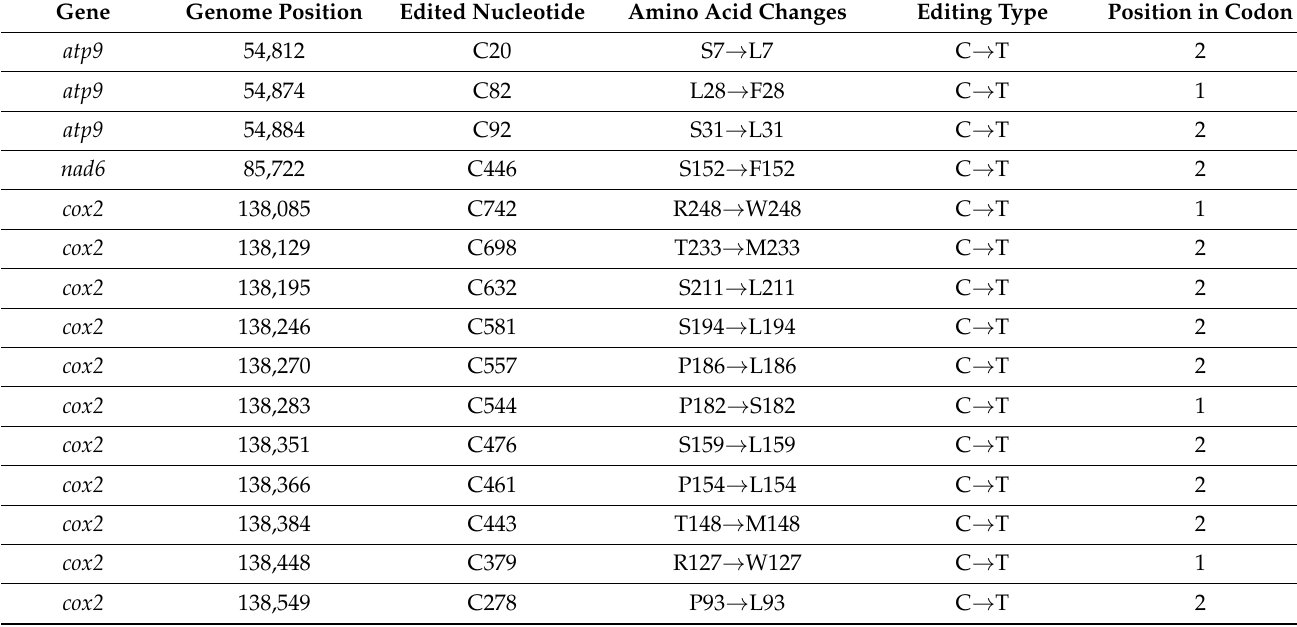
Table 2. RNA editing site in tea